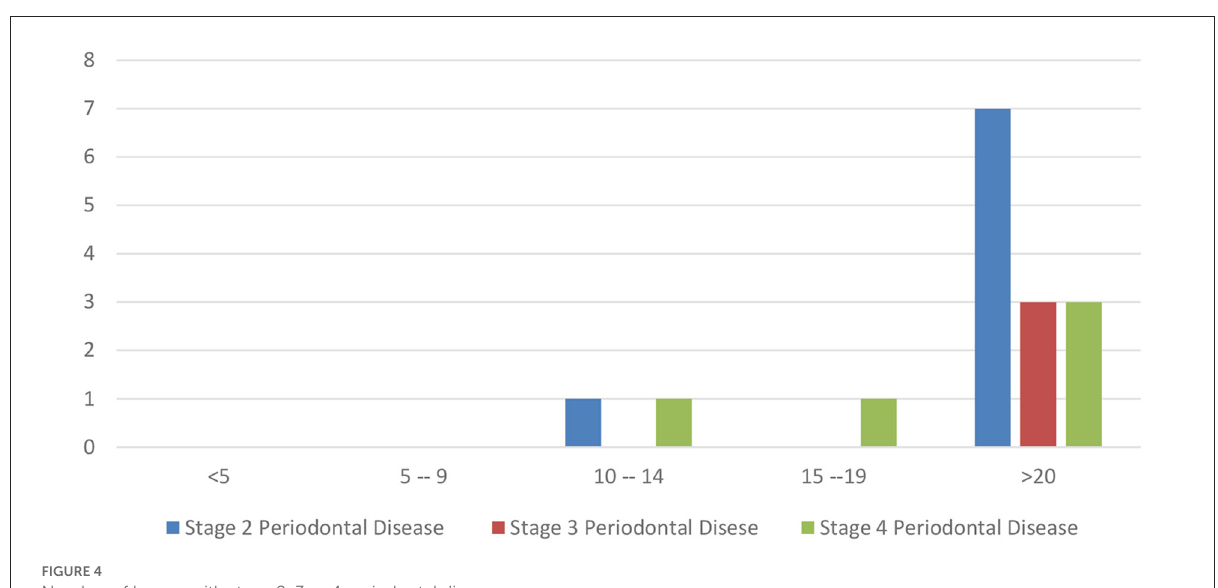
FIGURE4 Number of horses with stage 2, 3 or 4 periodontal